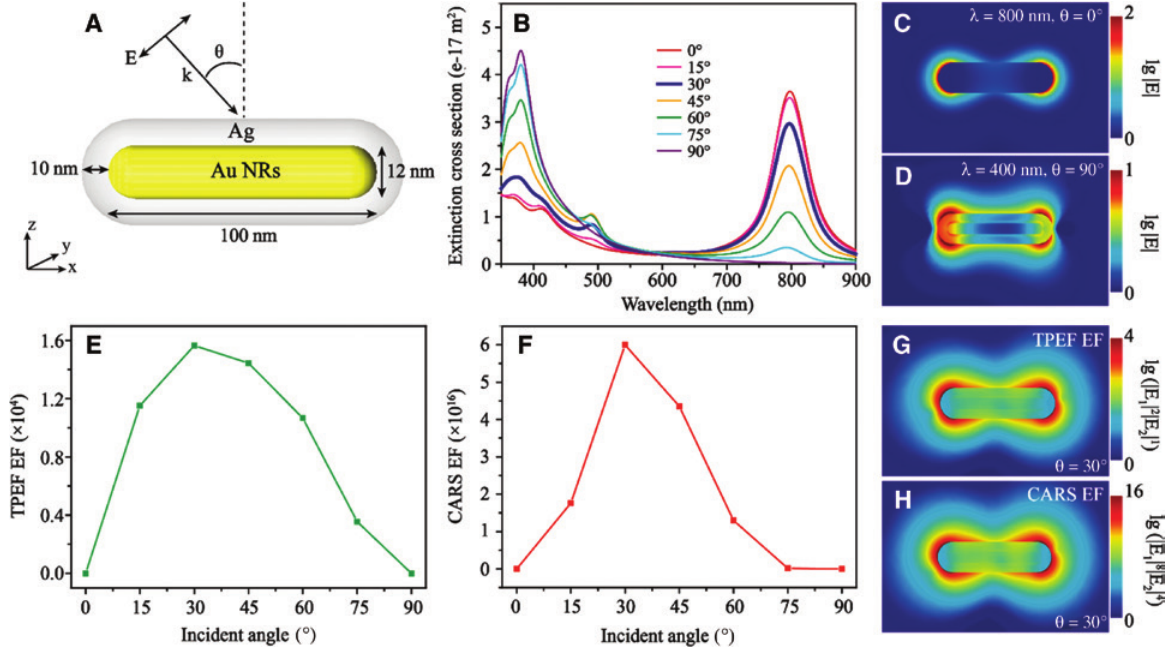
Figure 4: Nonlinear plasmonic enhancement of the Au@Ag nanorods. (A) Schematic of simulation model of the Au@Ag nanorods. (B) Incident angle-dependent extinction spectra from 0 ° to 90 ° with an increment of 15 ° . (C and D) Distributions of the electric field intensity of the Au@Ag nanorods with excitations of 800 and 400 nm, respectively. (E and F) The incident angle-dependent enhancement of the TPEF and CARS, respectively, and more detailed calculated results shown in the supporting information of Figure S6. (G and H) The respective distributions of the enhanced TPEF and